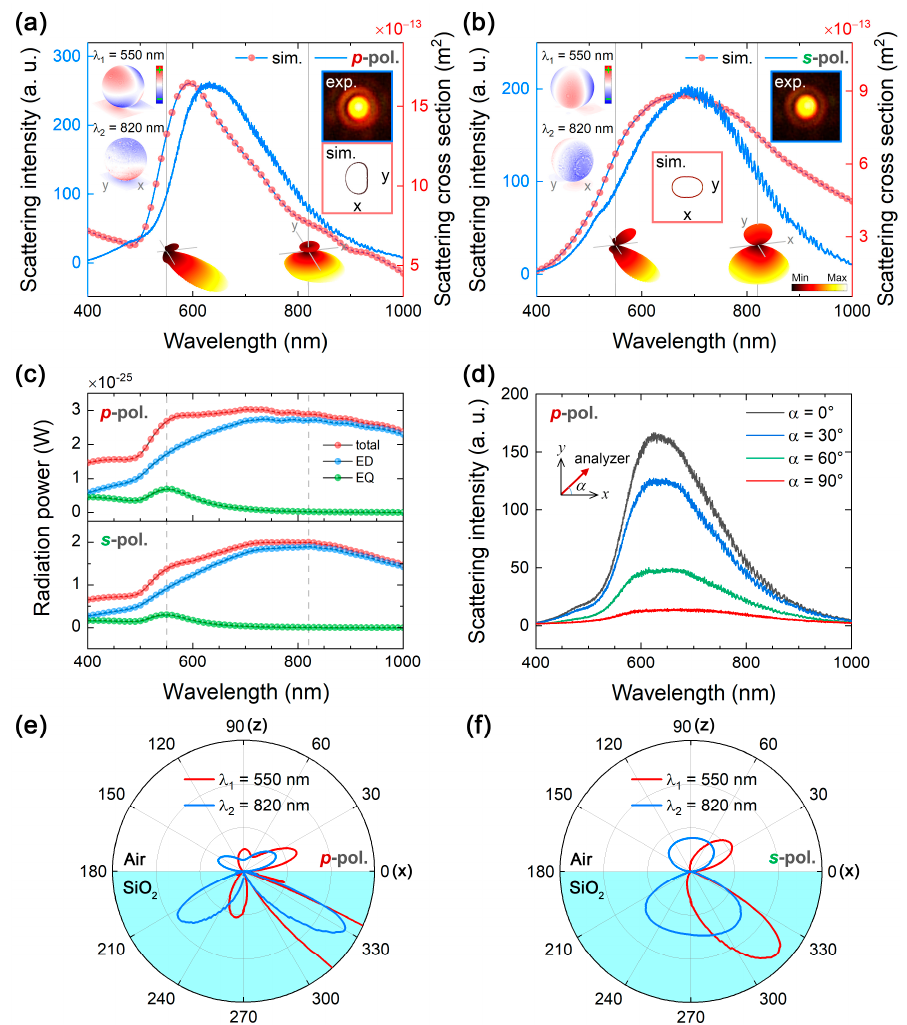
Figure 3. Scattering spectra measured and simulated for a GNS with d ~ 280 nm excited by ( a ) p - and ( b ) s -polarized light. Insets show the calculated three-dimensional far-field radiation patterns at 550 and 820 nm. The surface charge distributions at the two wavelengths are also provided as insets. ( c ) Multipole expansion of the total scattering of a GNS with d = 280 nm excited by using p - and s -polarized light. ( d ) Scattering spectra of the GNS with d ~ 280 nm excited by p -polarized light and measured by setting the polarization analyzer at different angles ( α ) of 0°, 30°, 60°, and 90°. The two-dimensional radiation patterns (on the xoz plane) calculated for the GNS excited by p- and s -polarized light are shown in ( e ) and ( f ),